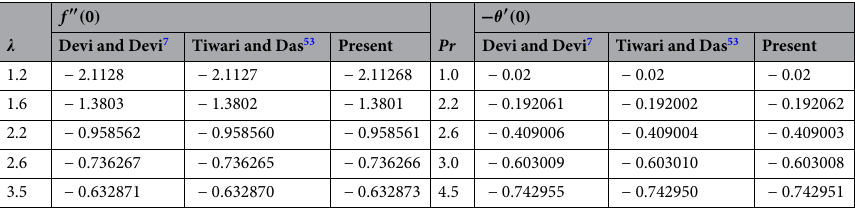
θ ′ ( 0 ) for regular fluid (φ 1 −